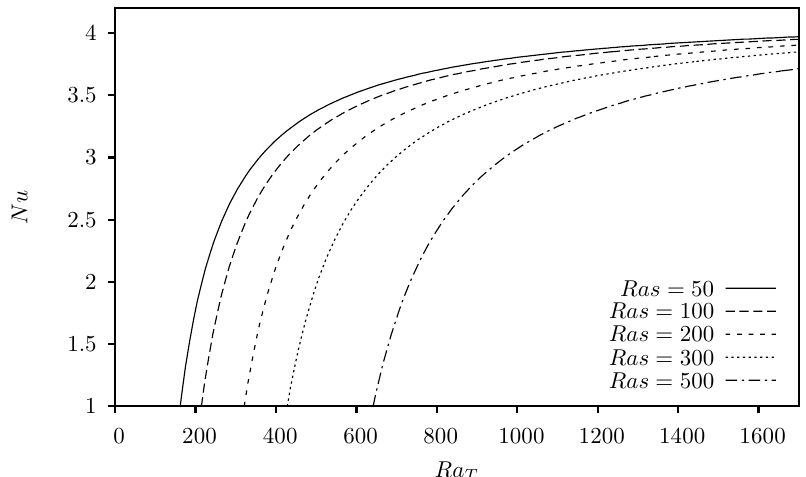
Figure 12. Variation of Nu with Ra T for steady nonlinear stability: effect of Ra s for Du = 0.05, R i = 1, Sr = 0.005, Le = 1.